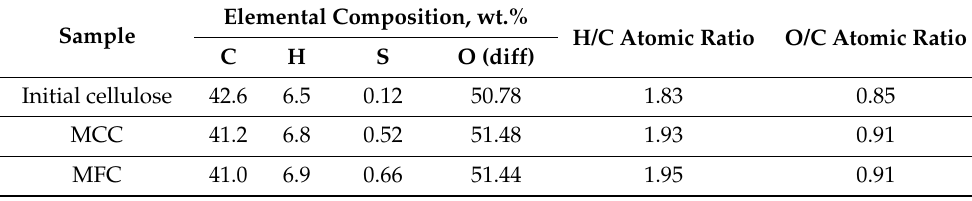
Table 1. Elemental composition of the initial cellulose and MCC and MFC samples.